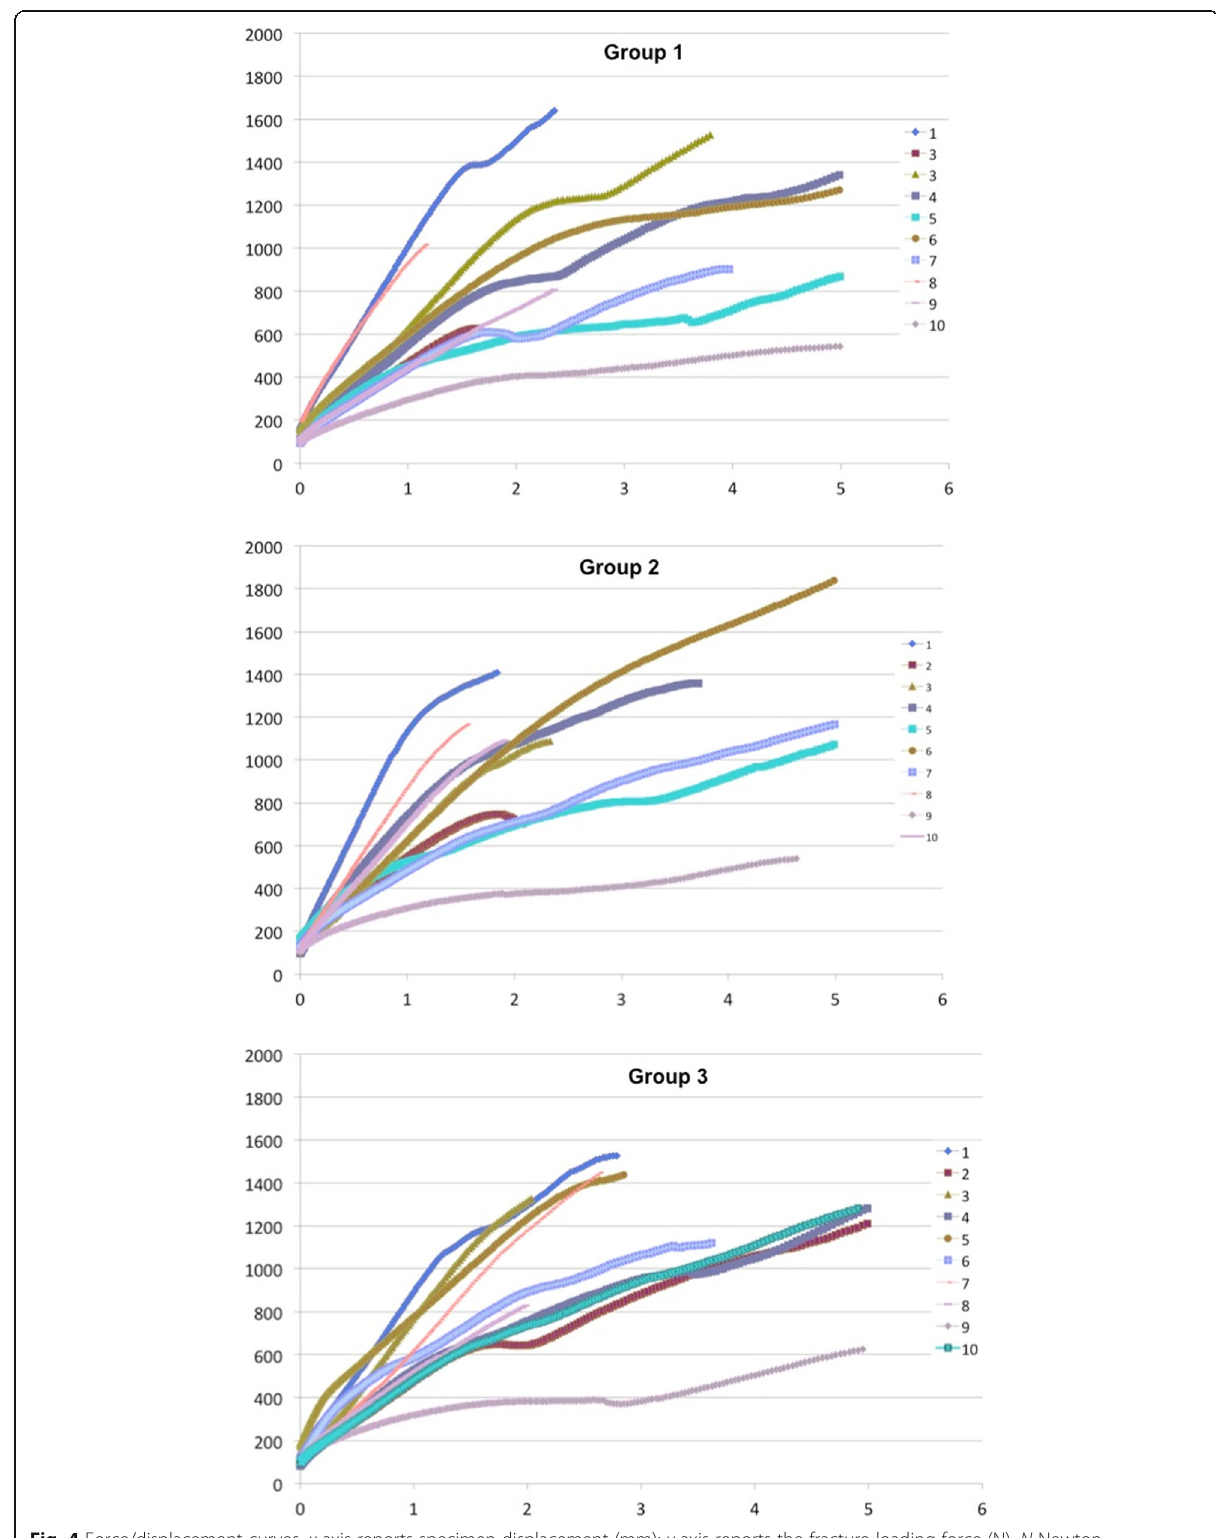
Fig. 4 Force/displacement curves. x- axis reports specimen displacement (mm); y- axis reports the fracture loading force (N). N